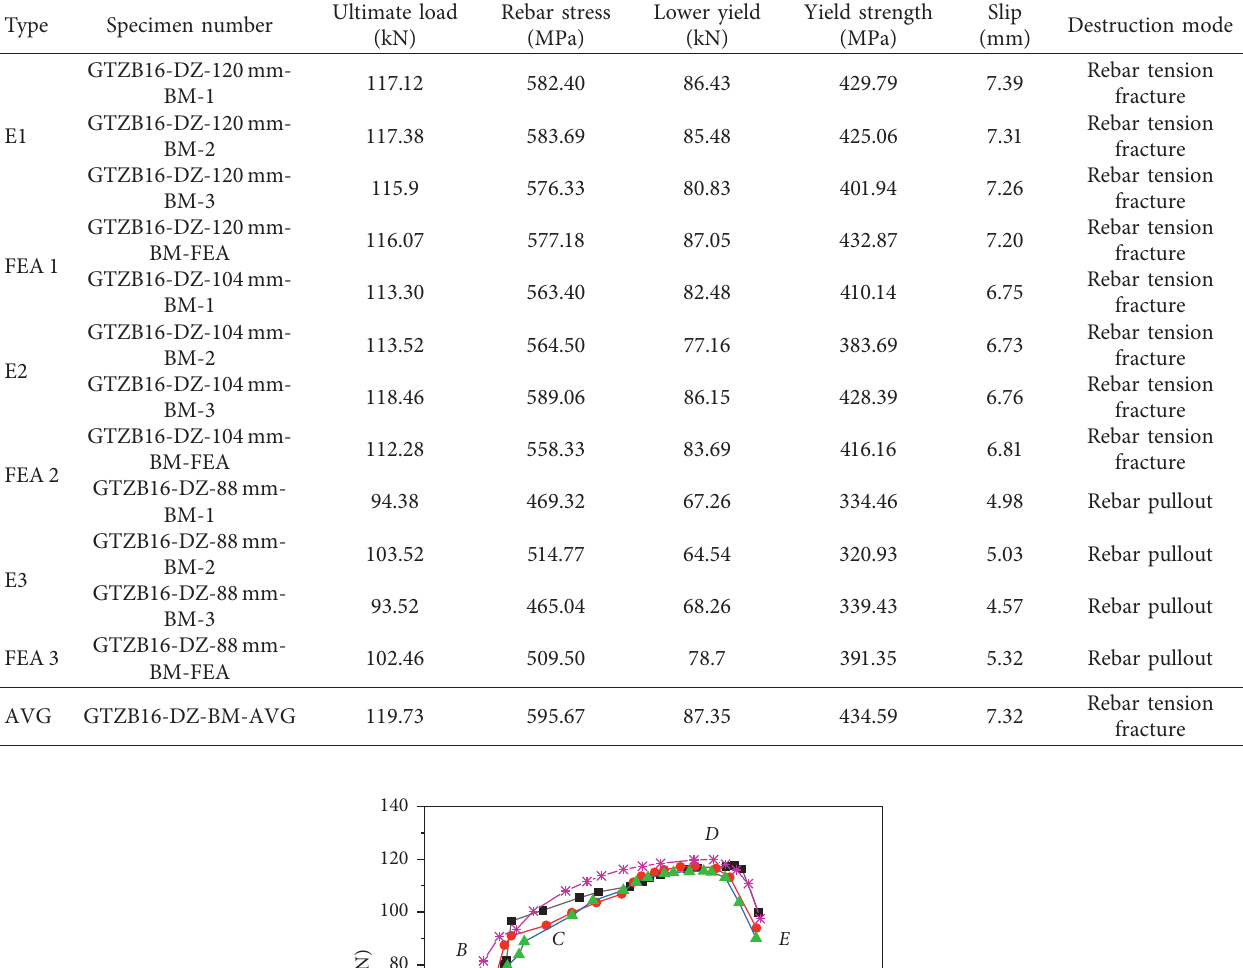
Table 8: The experiment and stimulation data of the insufficient anchoring length specimen.